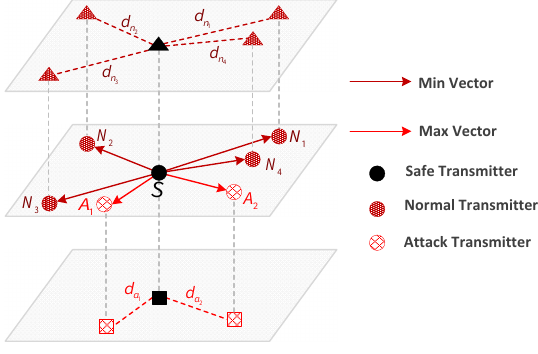
Figure 4. Interference